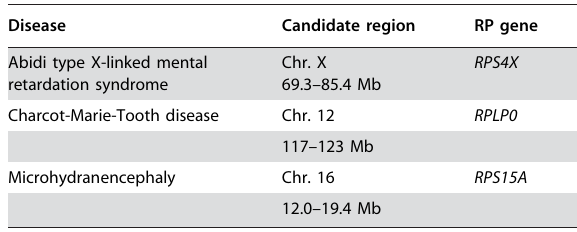
Table 2. The Candidate Chromosomal Regions Linked to